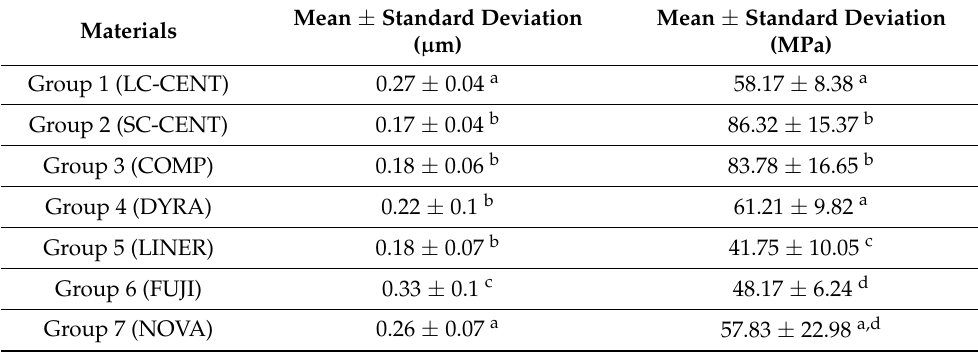
Table 2. Surface roughness and flexural strength values of the dental restorative